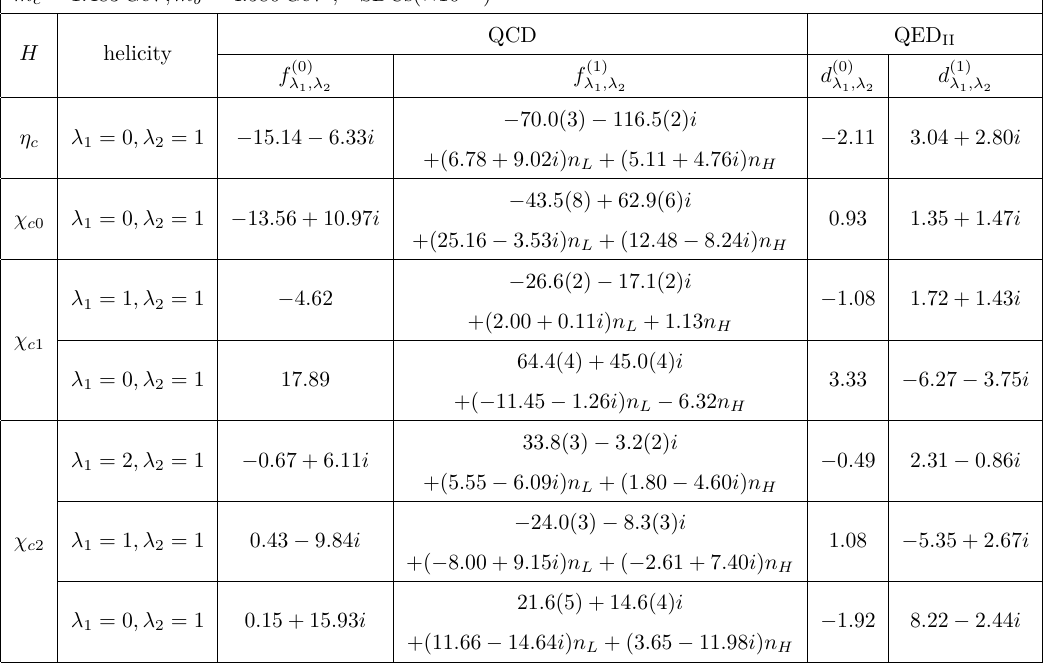
Table 1 . NRQCD predictions on the dimensionless helicity SDCs for m c = 1 . 483 GeV and m b = 4 . 580 GeV. The QED SDCs are evaluated in the QED II scheme. The errors in f (1) numerical